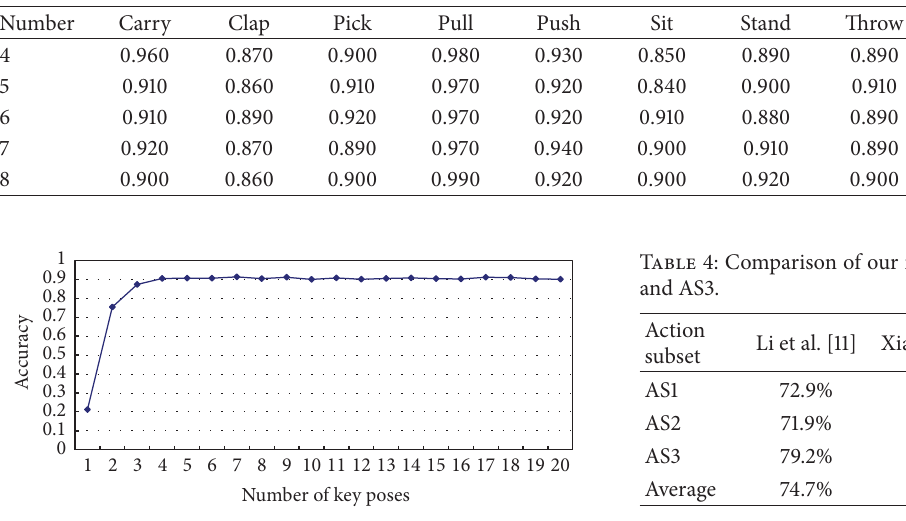
Table 2: Recognition accuracy on different number of key poses.